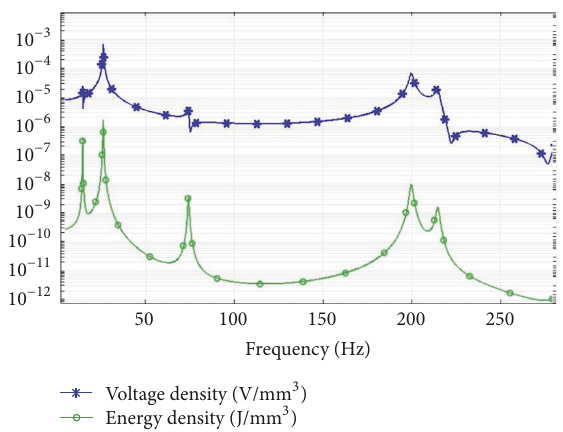
Figure 7: Electrical characteristics of the harvester.